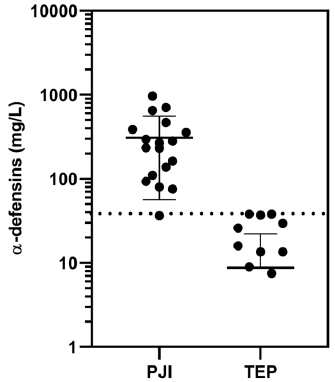
Figure 2. Synovial fluid α -defensins concentrations (logarithmic scale) for the patients with periprosthetic joint infections (PJI) versus those with aseptic total endoprosthesis (TEP), as determined by HPLC. The cutoff concentration (38 mg / mL) is represented by the dotted line.